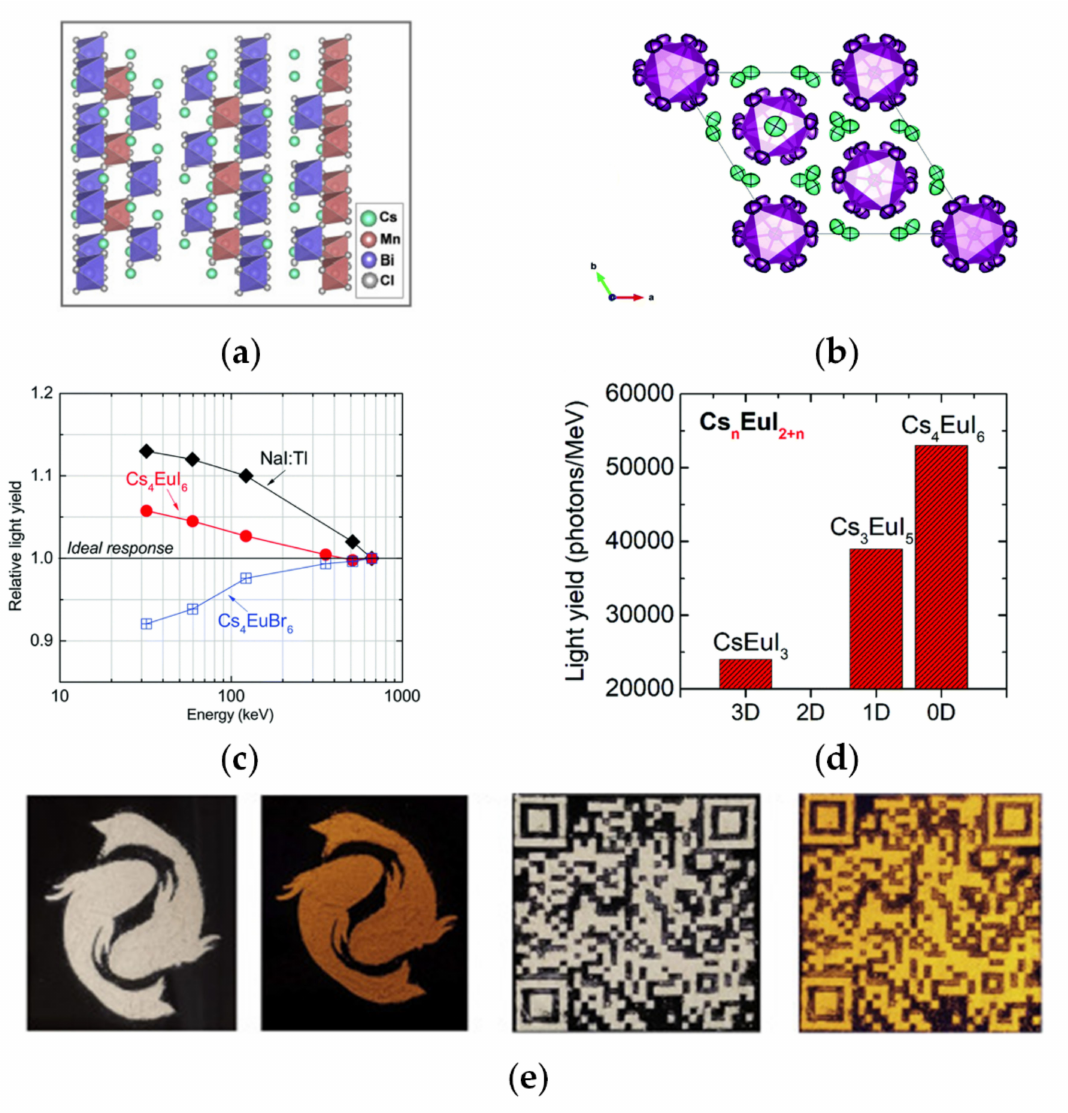
Figure 5. ( a ) The triple-layered two-dimensional structure diagram of Cs 4 MnBi 2 Cl 12. Adapted with permission from Ref. [98]. 2020, Elsevier; ( b ) crystal structure diagram of Cs 4 EuX 6 , where the purple polyhedral represents the tilted and isolated EuX 6 4 − octahedral, and green and purple ellipsoids represent Cs and X atoms. Adapted with permission from Ref. [95]. 2018, Royal Society of Chemistry; ( c ) dominant factor of Cs 4 EuI 6 and Cs 4 EuBr 6 Adapted with permission from Ref. [95]. 2018, Royal Society of Chemistry; ( d ) relationship between the dimension and scintillation light yield in Cs n EuI 2+n family. Adapted with permission from Ref. [95]. 2018, Royal Society of Chemistry; ( e ) patterned fish-like images and QR code of Cs 4 MnBi 2 Cl 12 under (left) visible and (right) UV light, respectively. Adapted with permission from Ref. [98]. 2020,